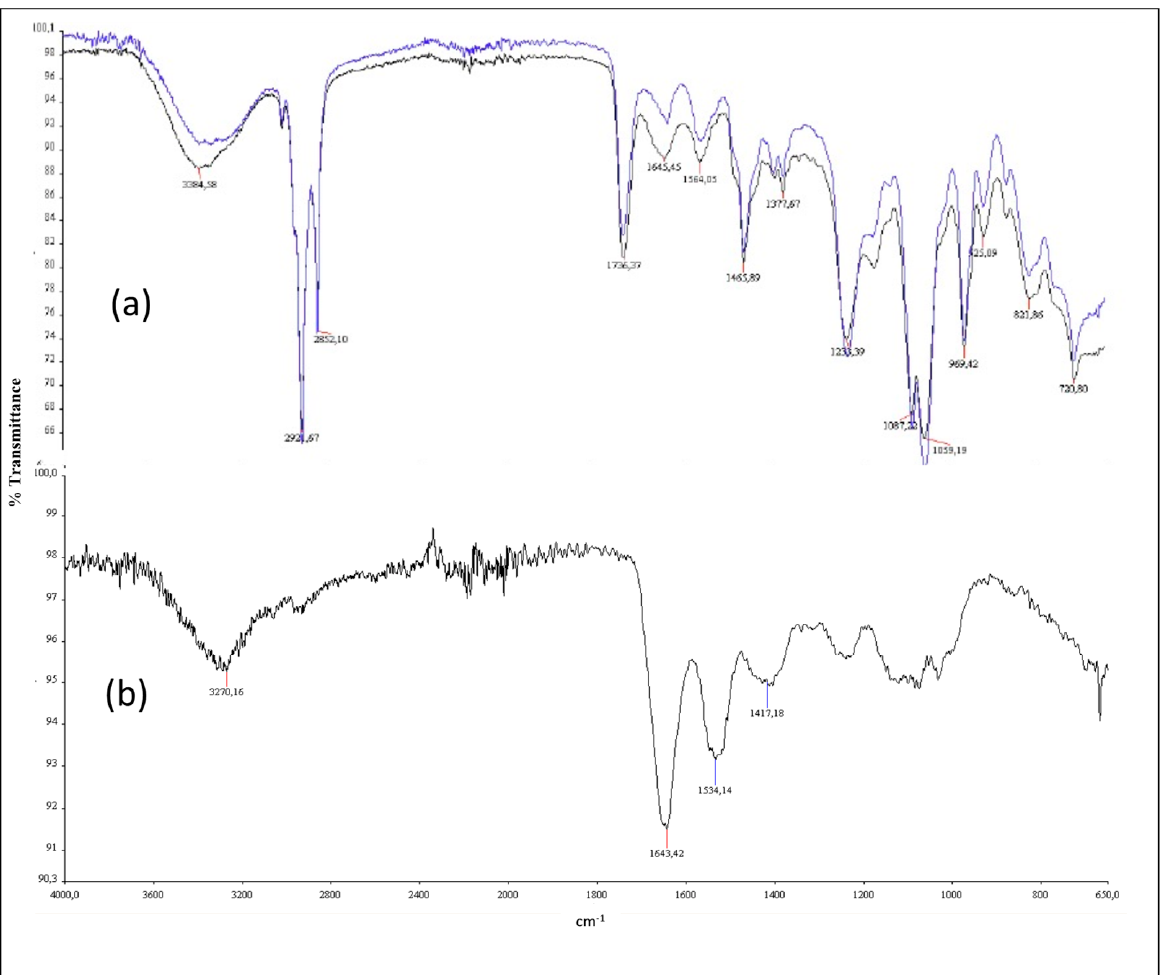
Figure 3. IR spectra of L (( a ), blue), LHC (( a ), black) and crude HC ( b ) .